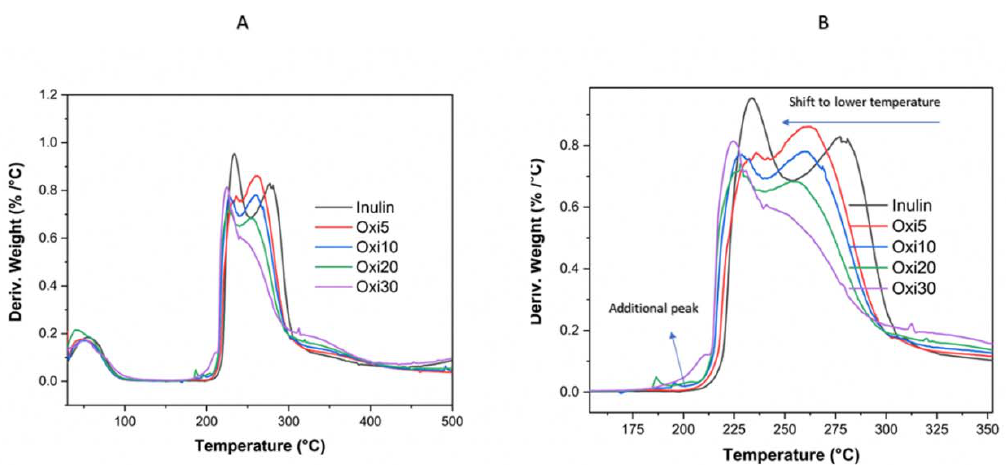
Figure 5. ( A , B ) TGA thermograms of unmodified raw inulin and Oxi5, Oxi10, Oxi20, and Oxi30 samples.